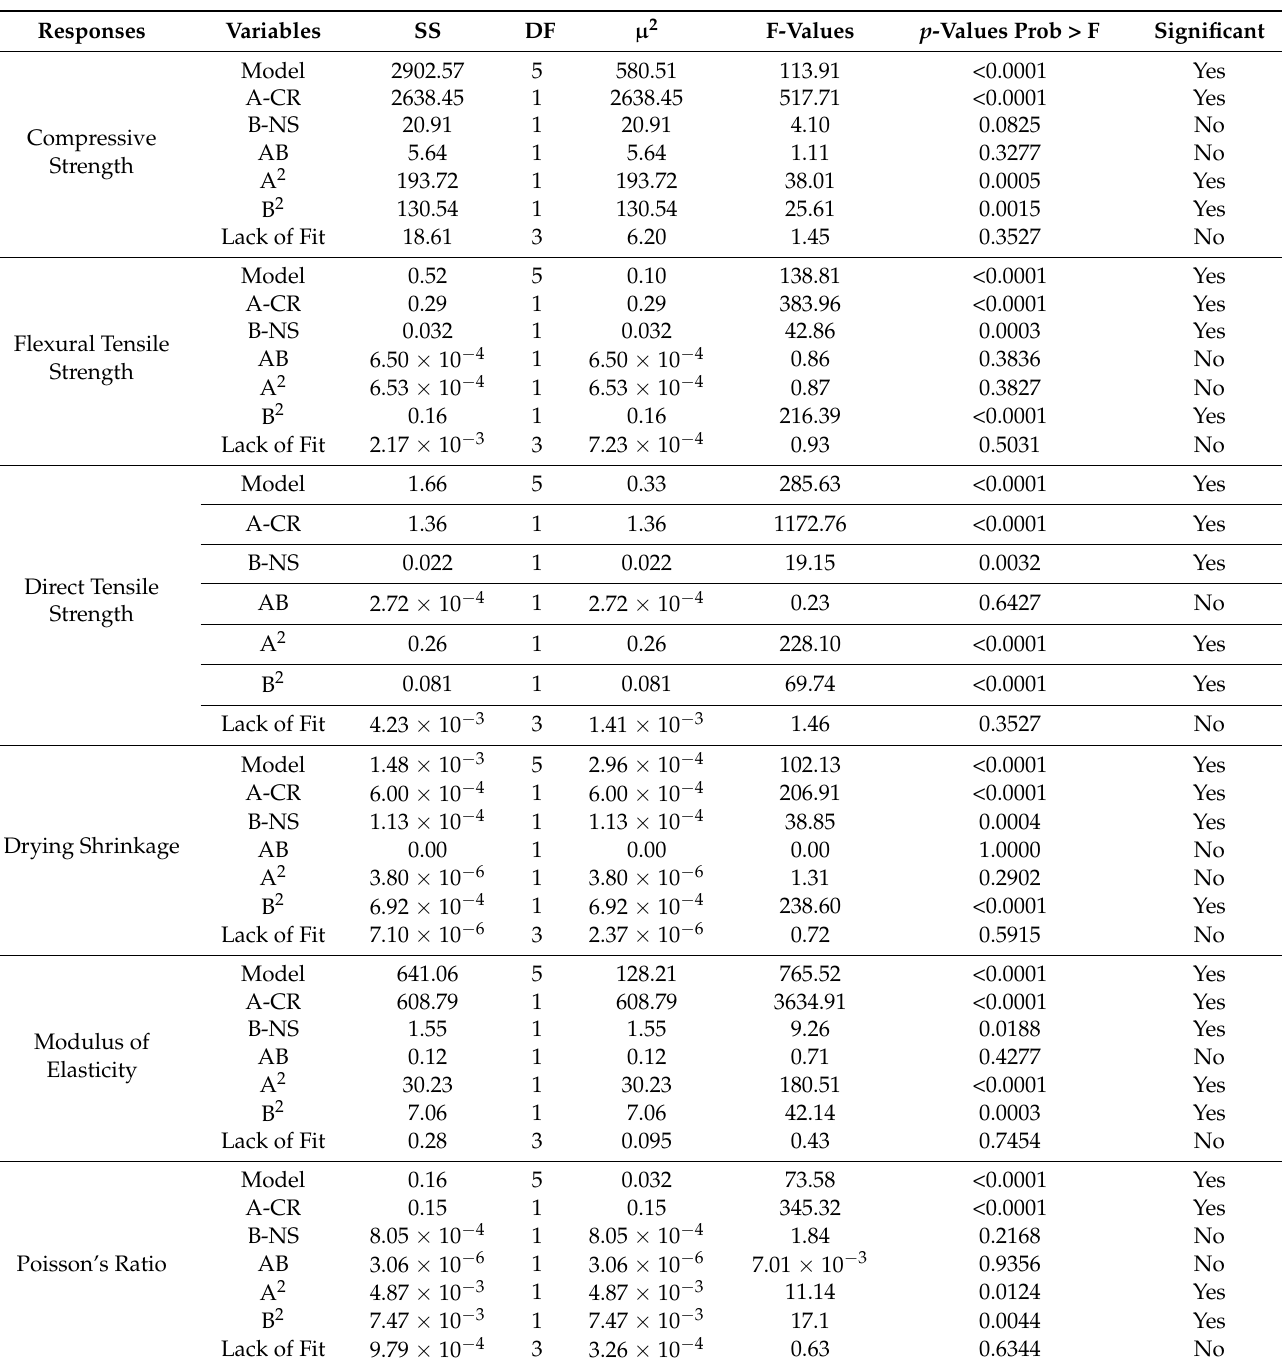
Table 8. ANOVA for developed response